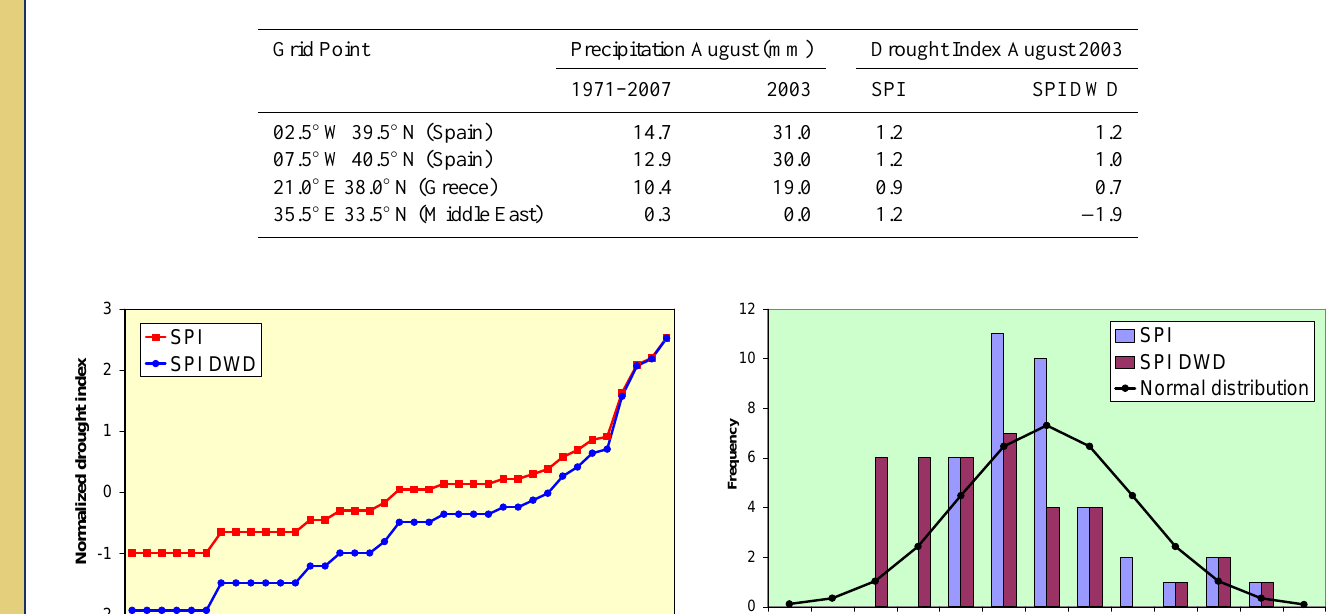
Table 1. Comparison of the SPI and the SPI DWD for several grid points.